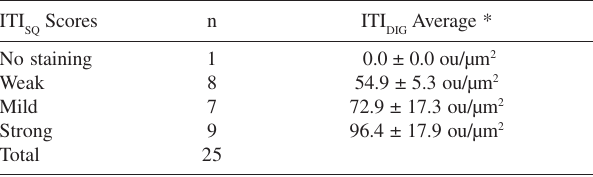
) according to the scores DIG ). SQ